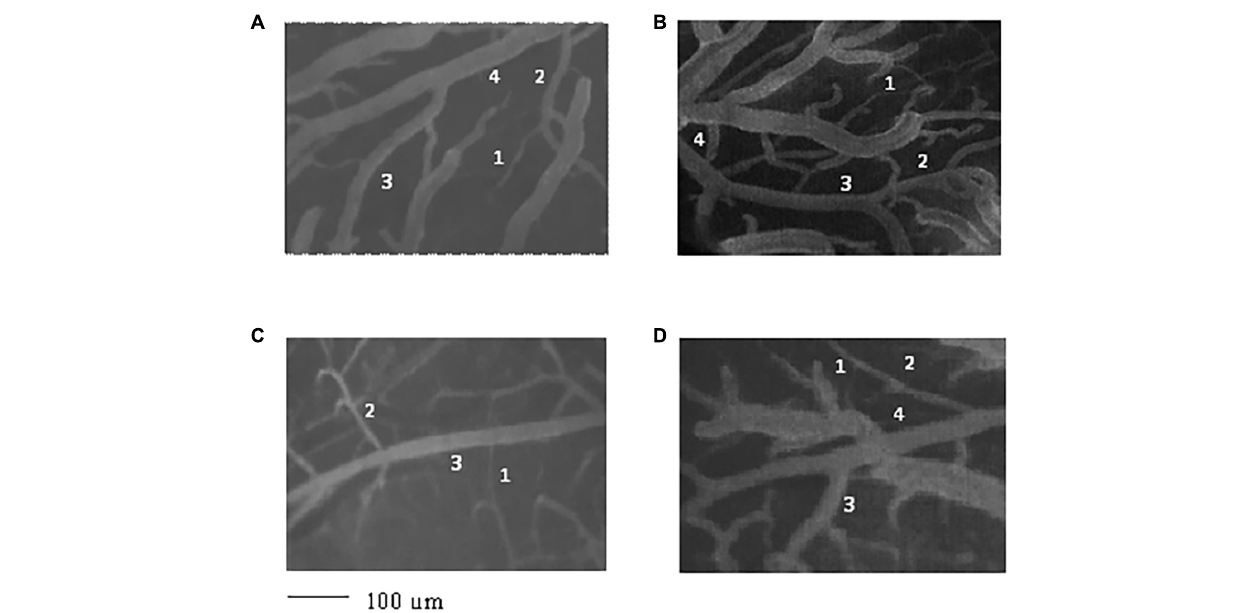
FIGURE 1 | Image of the pial microvascular network of young spontaneously hypertensive rats (SHRs) (A) , young normotensive age-matched rats (B) , adult SHRs (C) , and adult normotensive age-matched rats (D) , obtained through a fluorescence microscope equipped with specific dedicated software. The different orders of arterioles are indicated with 1 , 2 , 3 , and 4